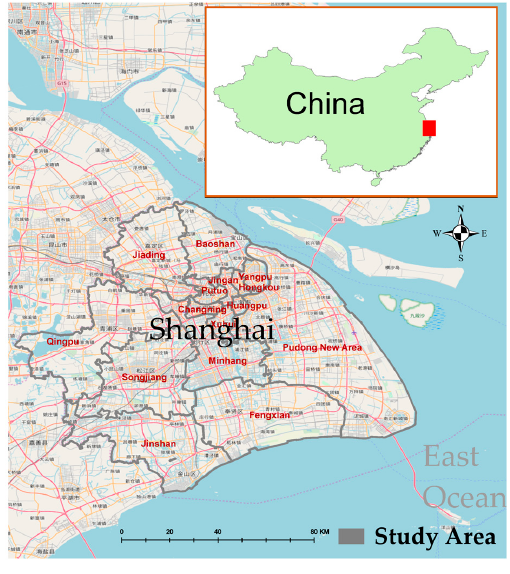
Figure 1. Study area.